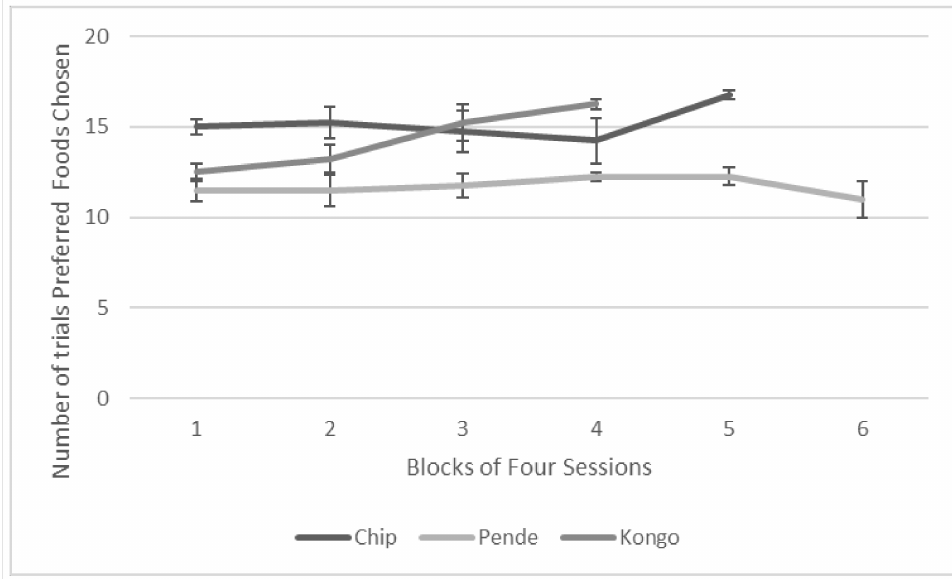
Figure 6. Average number of trials preferred foods were chosen in blocks of four sessions. Error bars represent standard